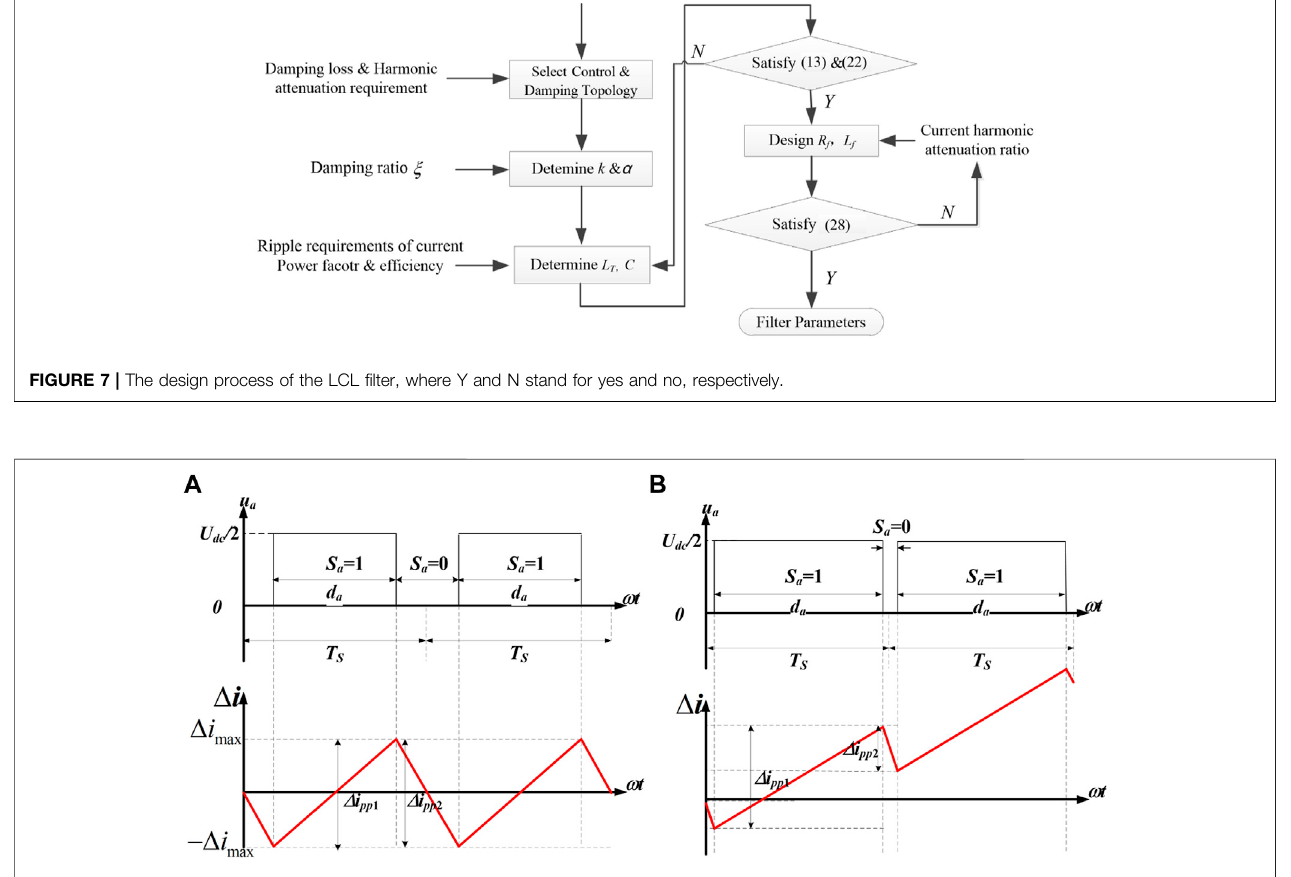
FIGURE 8 | Corresponding situation of phase voltage pulse and phase current ripple (phase a ). (A) i a = i max . (B) i max = 0.